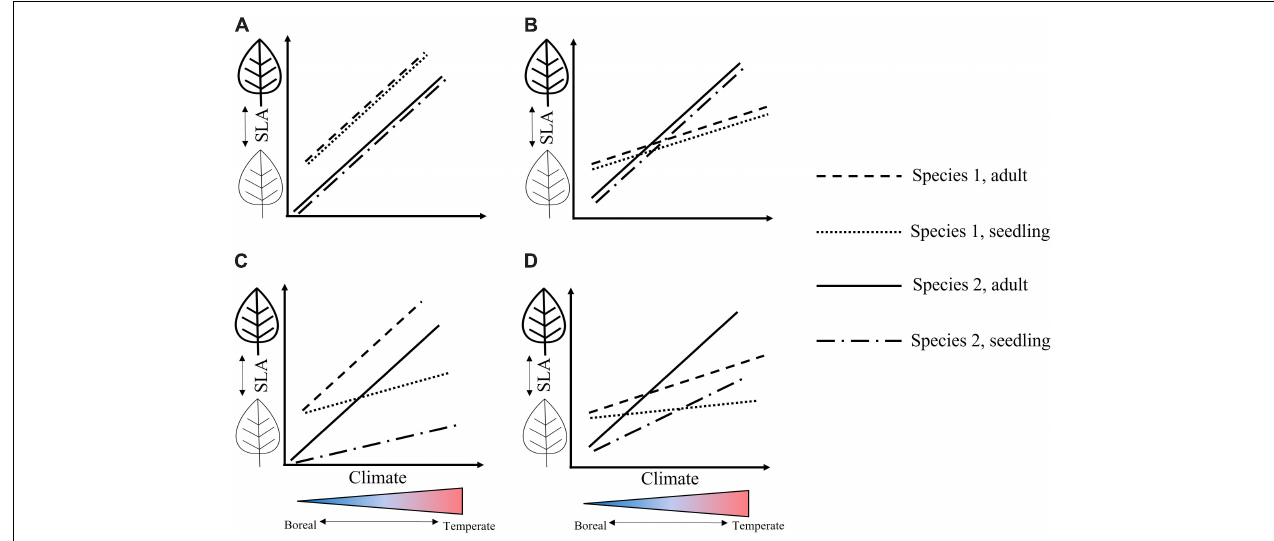
FIGURE 1 | Hypothetical responses of specific leaf area (SLA) across an environmental gradient. In communities where species traits respond equivalently to a climate variable across species and their developmental stages, (A) mean trait values (shown as full or dashed lines) will parallel one another across the environmental gradient. (B) Species with differing responses to a climate variable (equally across life stages) may show shifts in trait rankings along an environmental gradient, or over time in a changing environment, resulting in species crossover. (C) Species whose responses are based on developmental stage may show contrasting patterns of species crossover. (D) Species may show more complex trait rank shifts if developmental stages have differing responses to a climate variable.